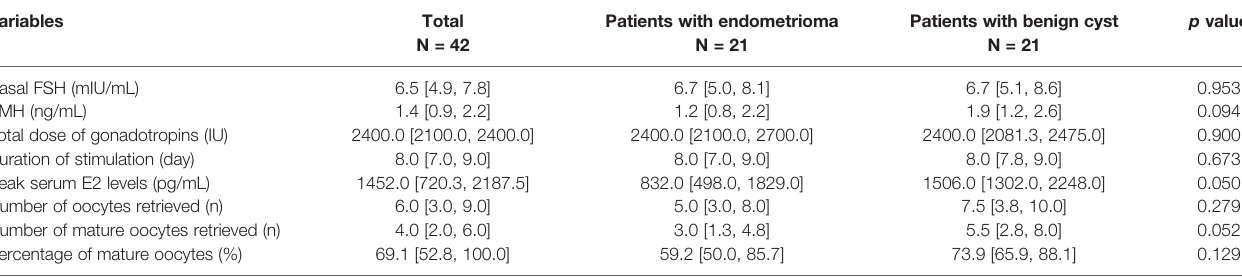
TABLE 4 | Comparison of clinical characteristics and fi rst controlled ovarian stimulation cycle outcomes of patients with endometrioma and patients with a benign ovarian cyst. Variables